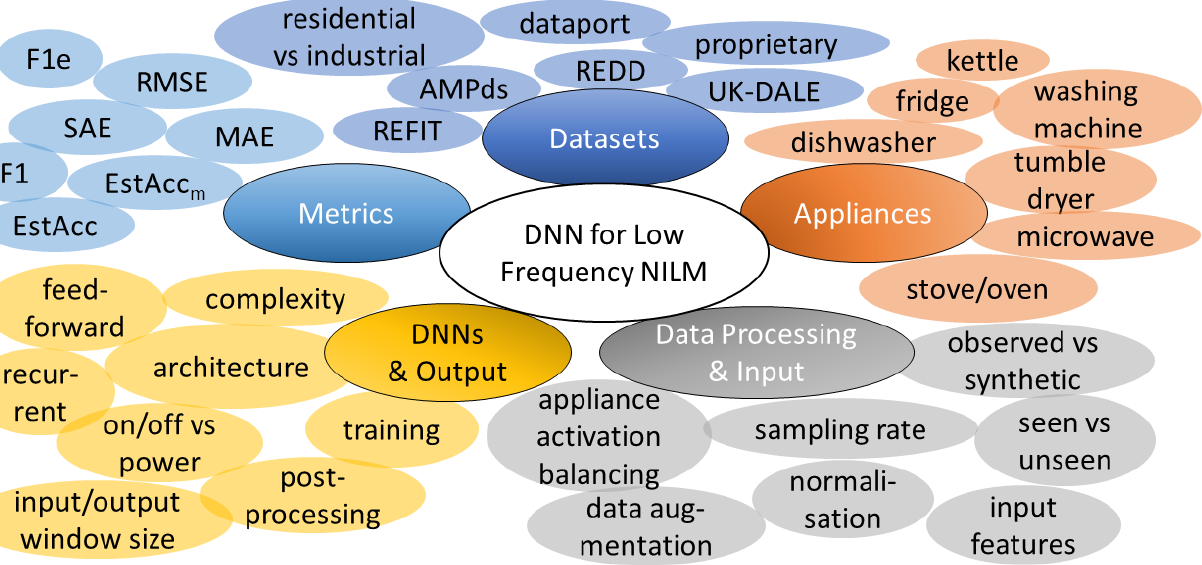
Figure 1. Illustration of the main degrees of freedom for DNN-NILM research. Colors indicate a loose grouping and should not be understood as a